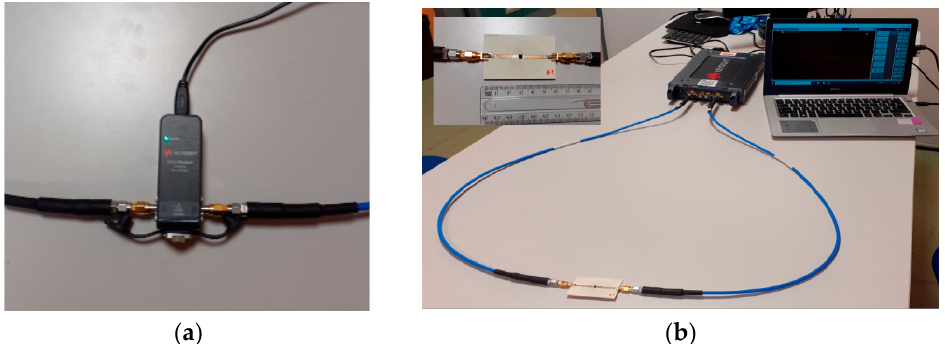
Figure 4. Scattering parameters measurements: ( a ) measurement setup and microstrip line with film in the inset; ( b ) electronic calibration kit.